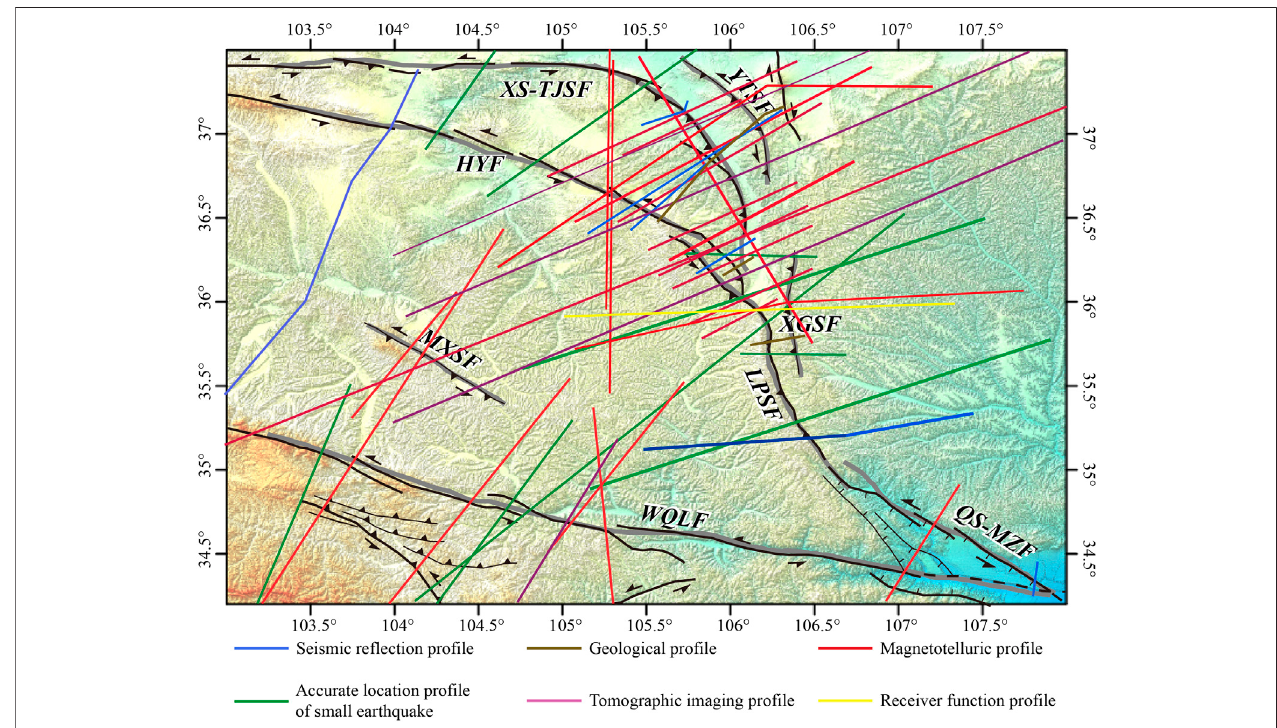
FIGURE 7 | Distribution of modeling pro fi les in the V3 model. The modeling pro fi les corresponding to each fault, pro fi le types, and references are shown in the Table 1 .